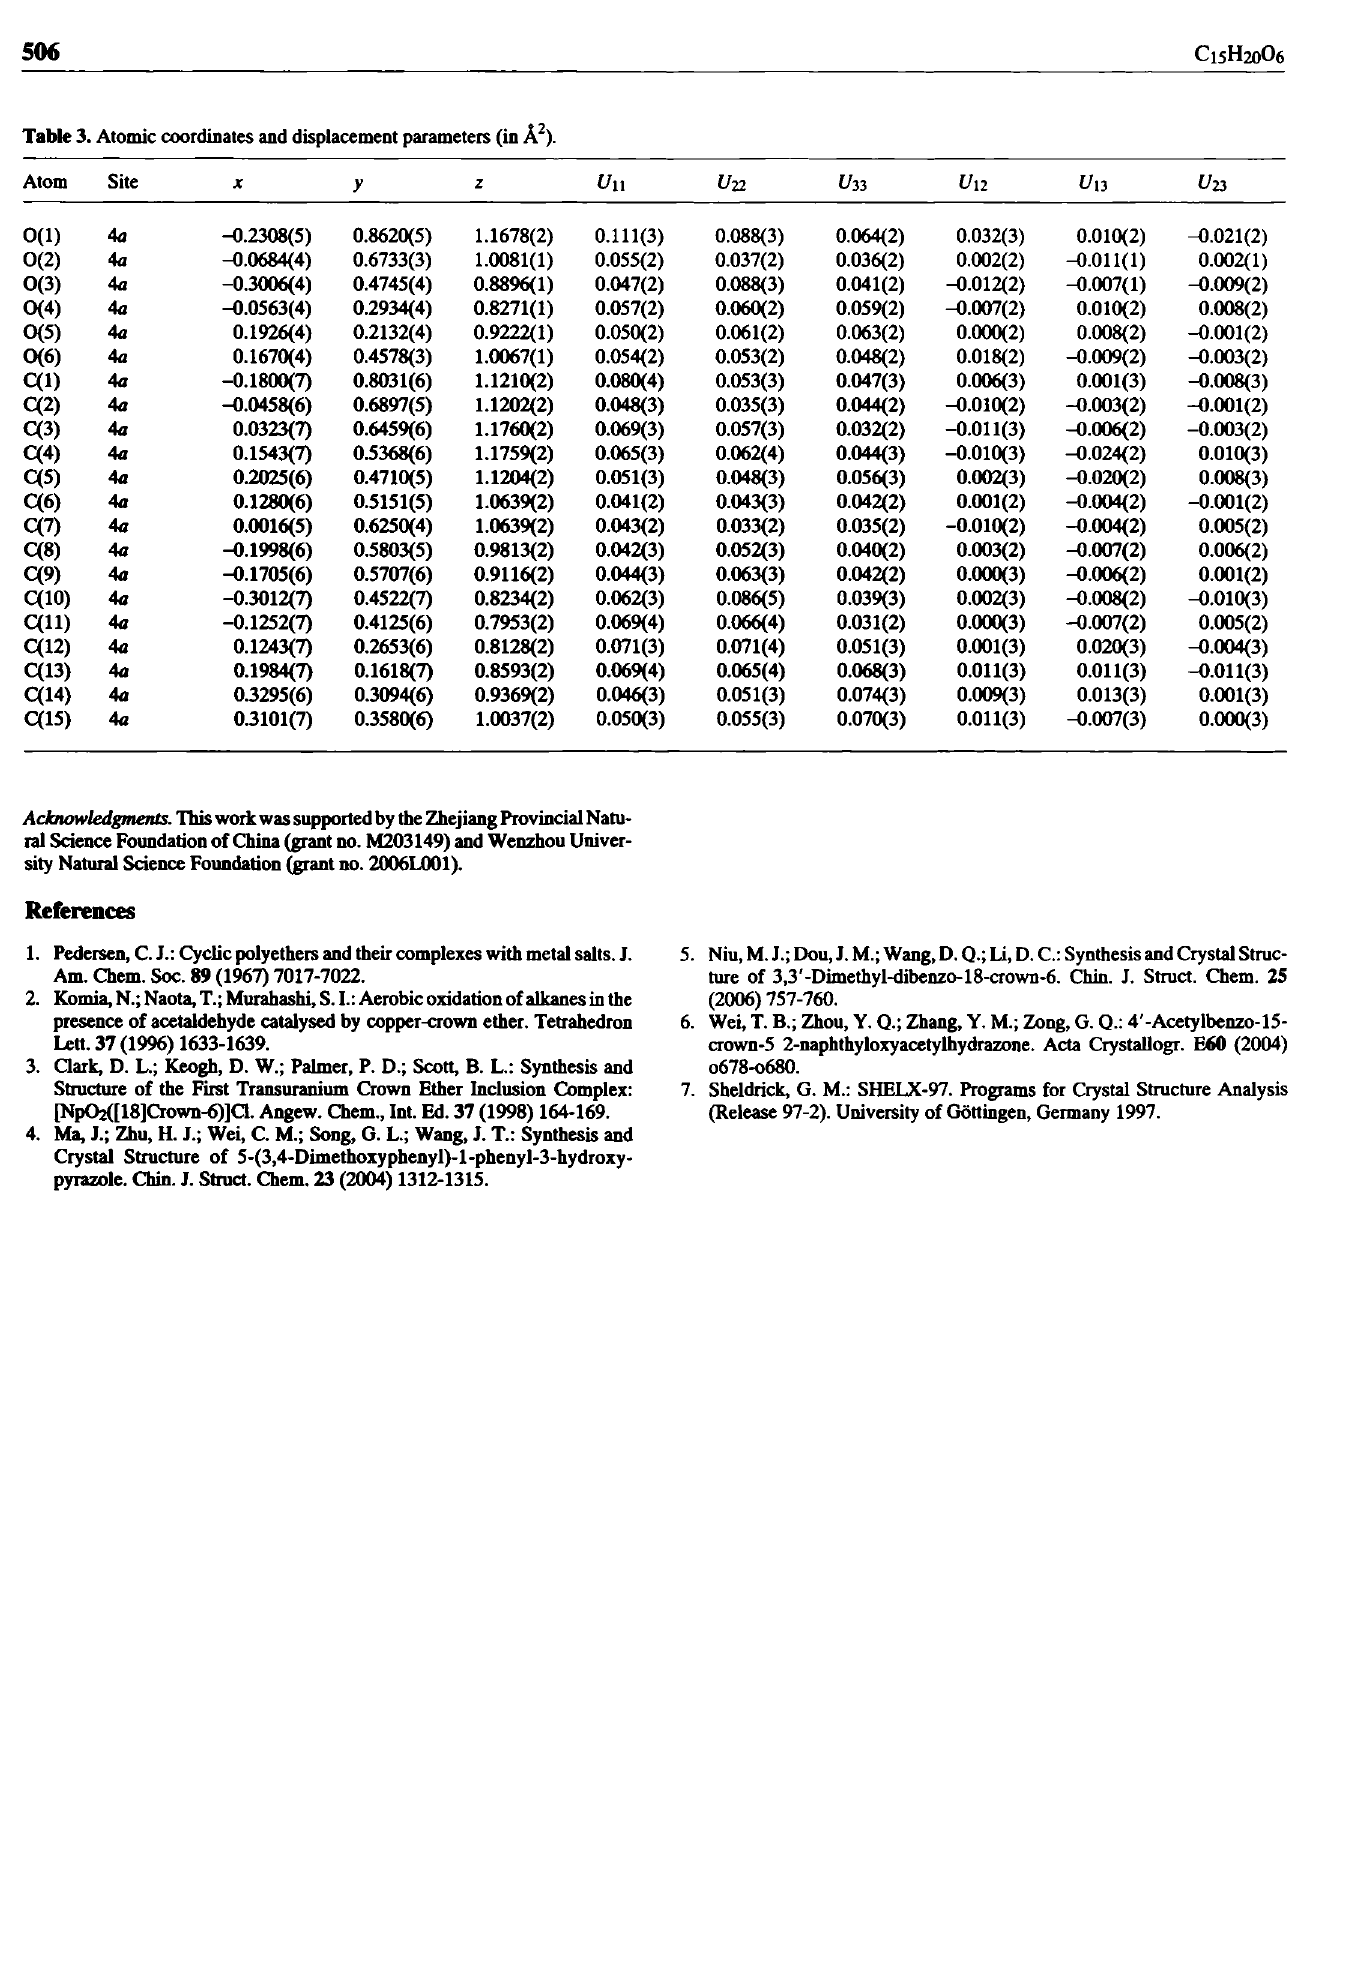
Table 3. Atomic coordinates and displacement parameters (in Ä 2